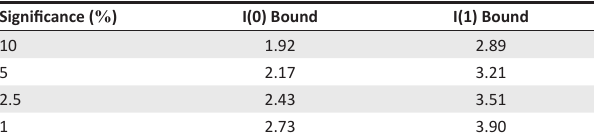
TABLE 5: Critical value bounds.